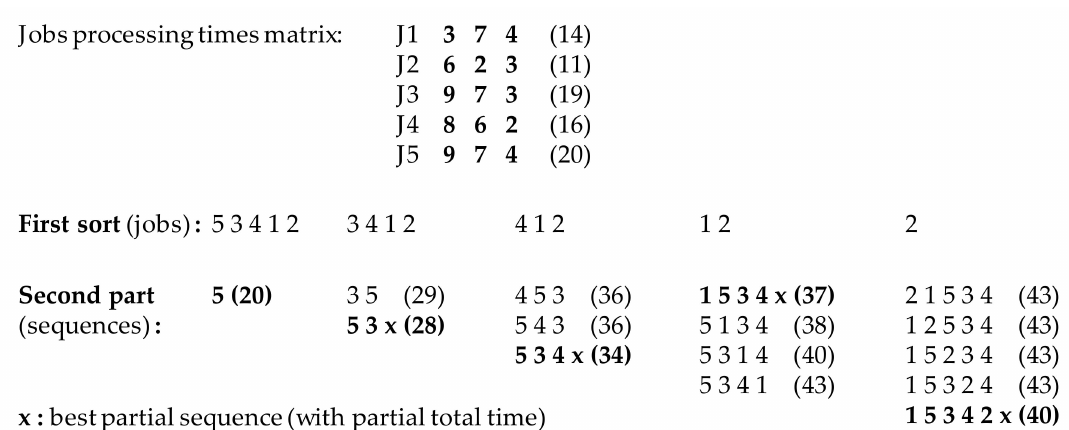
Figure 2. Illustration of the two points of choice in the Nawaz, Enscore, and Ham (NEH) heuristic in a five jobs, three machines